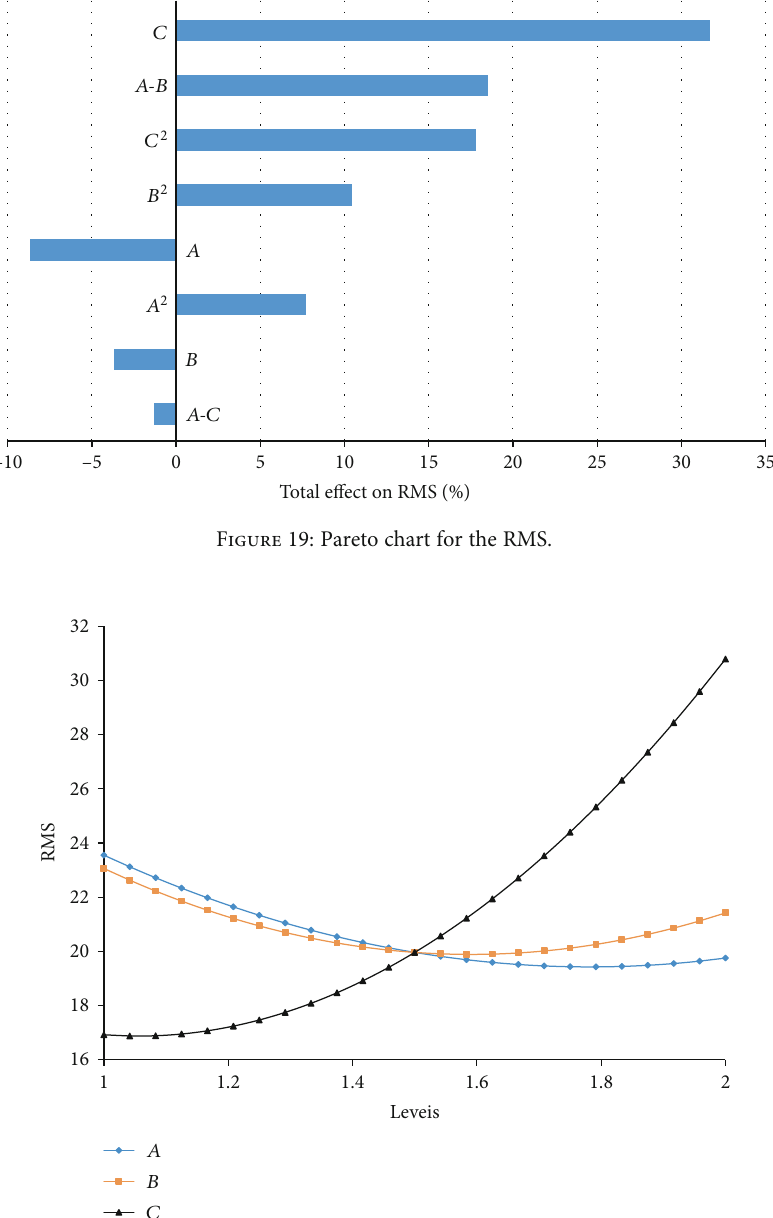
Figure 20: Main e ff ect plot for the